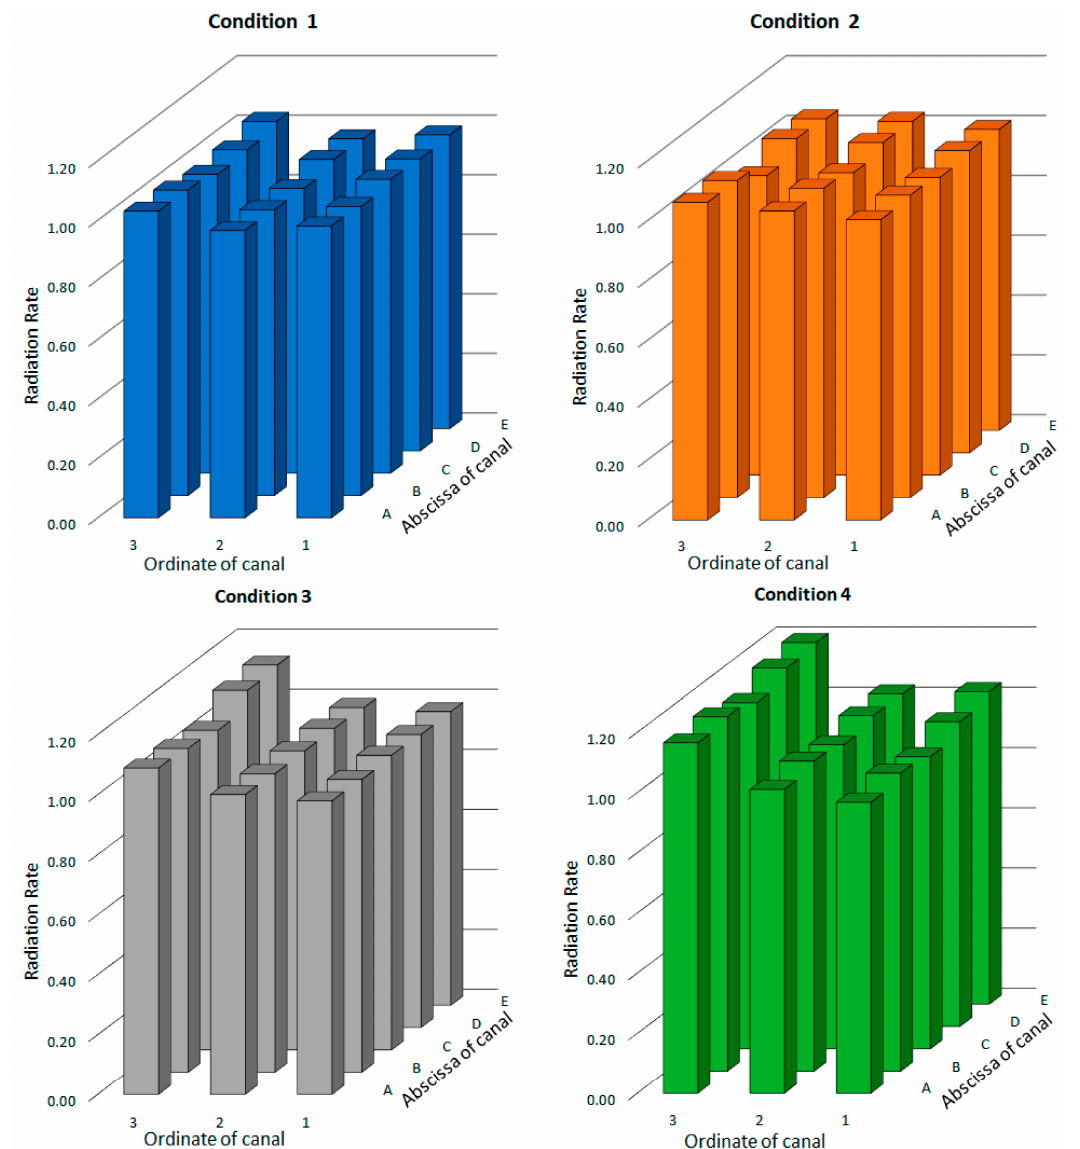
Figure 5. Graphic representation of the means of the Radiation Ratios indices obtained, for each condition.